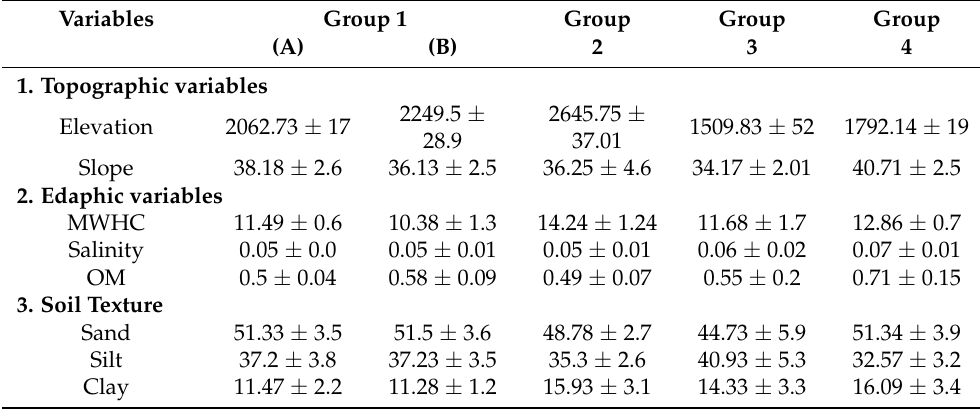
Table 6. Mean values ± SE of environmental variables based on four groups derived from Ward’s cluster analysis using understory vegetation data of 40